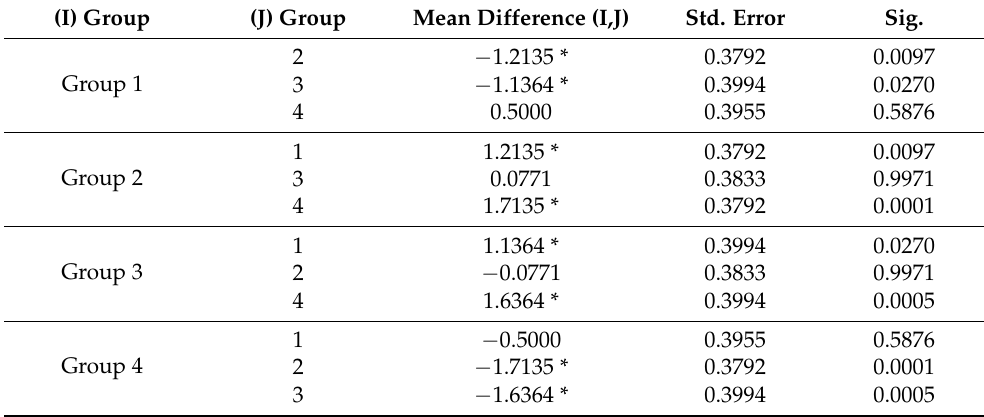
Table 4. Multiple comparison test to attitude toward content information